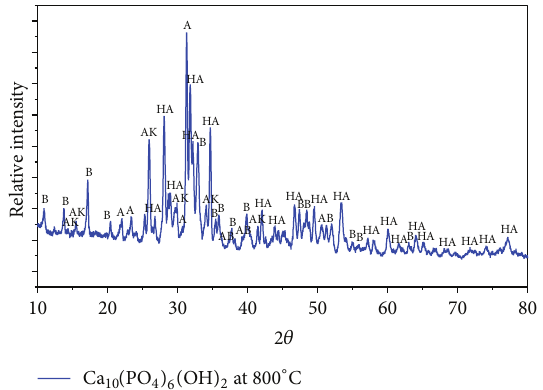
Figure 6: Diffractogram of sample were sintered at 800 ∘ C, where, HA = Ca 10 (PO 4 ) 6 (OH) 2 , A= 𝛼 -TKF = 𝛼 -Ca 3 (PO 4 ) 2 , B = 𝛽 -TKF = 𝛽 Ca 3 (PO 4 ) 2 , AK = AKA = Ca 10 (PO 4 ) 6 CO 3 and AB = AKB = Ca 10 (PO 4 ) 6 CO 3 (OH) 2